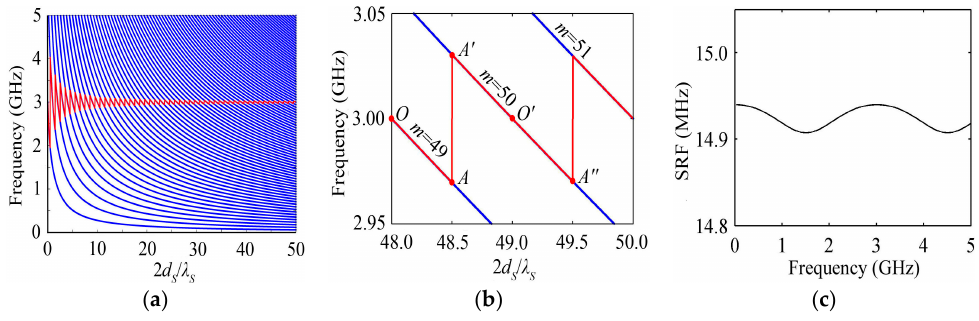
Figure 2. The HBAR consisting of ZnO 1.05 μ m /Sapphire; ( a ) The variation curve of the resonance frequency with the substrate thickness; ( b ) The partial enlarged drawing of Figure 2a; ( c ) The change of SRF with the frequency when the substrate thickness 2 d S / λ S = 200.